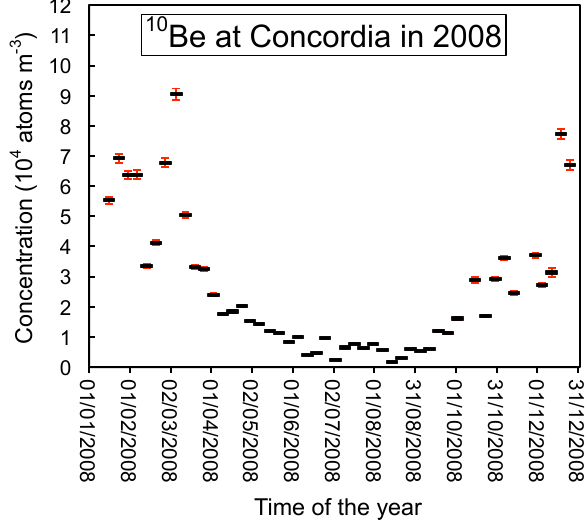
Figure 9. Annual cycle of 10 Be concentrations in 2008 at Concor- dia. Vertical bars (in red) refer to AMS uncertainties (see Sect. 2).